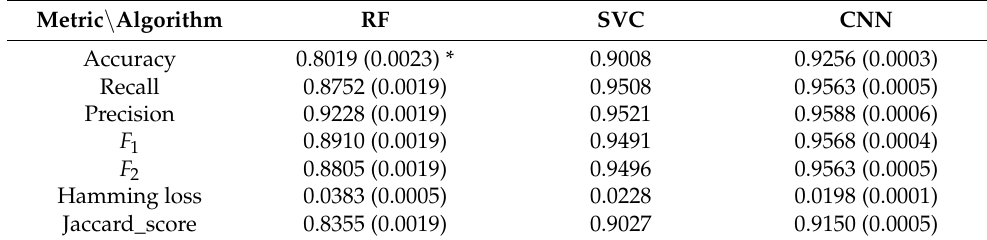
Table 2. Classification performance in experiment 1.